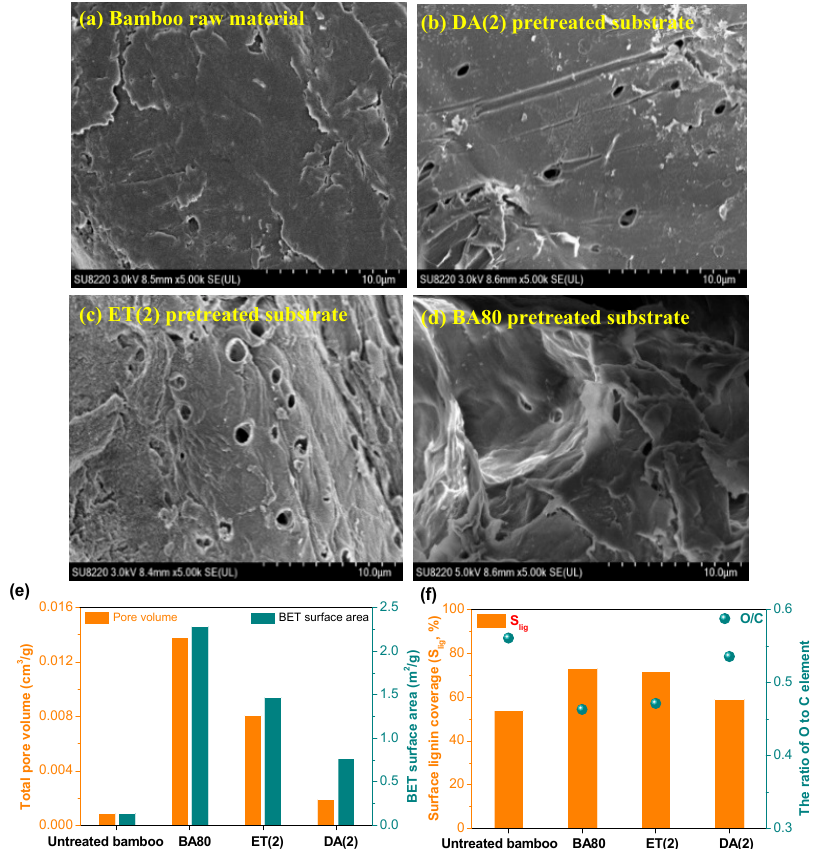
Figure 5. ( a – d ) SEM images, ( e ) total pore volume and BET surface area, and ( f ) surface lignin coverage (S lig ) of bamboo raw material and pretreated solid substrates. Three pretreatments (DA(2), ET(2), and BA80) were conducted under optimized conditions that are detailed in Figure